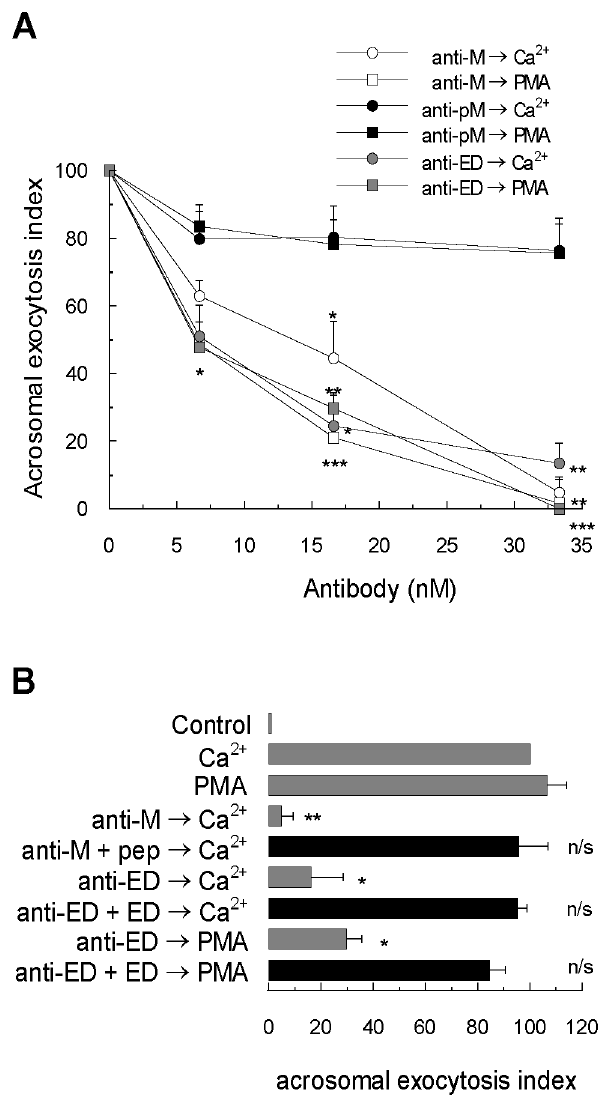
Figure 2. MARCKS participates in acrosomal exocytosis. ( A ) Permeabilized sperm were incubated for 15 minutes at 37 u C in the presence of increasing concentrations of anti-MARCKS N-19 antibody (anti-M, white symbols), anti-MARCKS ED (anti-ED, gray symbols) and anti-phospho-MARCKS (anti-pM, black symbols). Acrosomal exocytosis was initiated by adding 10 m M free Ca 2 + (circles) or 200 nM PMA (squares). For all conditions, the incubation continued for an additional 15 minutes and acrosomes were evaluated by lectin binding. ( B ) Permeabilized sperm were incubated for 15 minutes at 37 u C in the presence of 33 nM anti-MARCKS N-19 antibody (anti-M) preincubated with an excess (1: 10) of blocking peptide MARCKS N-19 (anti-M + pep) and in the presence of 33 nM anti-MARCKS ED antibody (anti-ED) preincubated with an excess (1:10) of MARCKS effector domain (anti- ED + ED). Acrosomal exocytosis was then initiated by adding 10 m M free